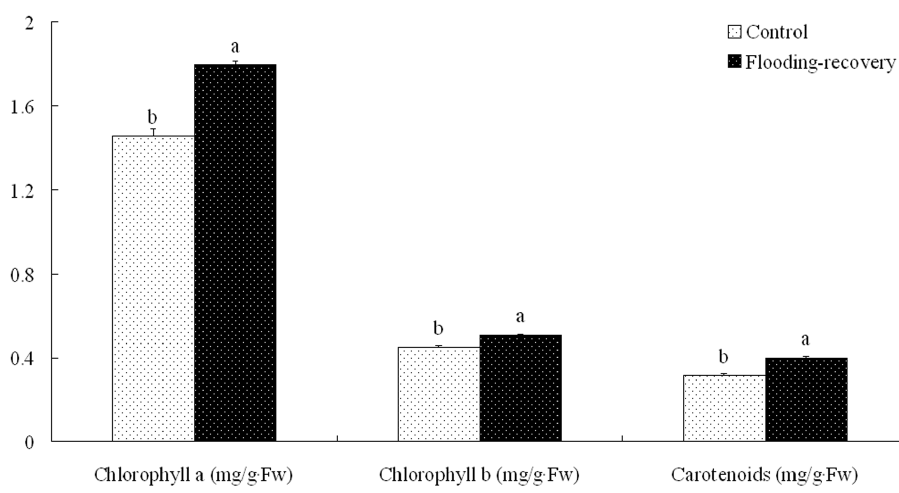
Figure 1. Comparable analyses of pigment contents in L.chinense during the recovery stage after winter flooding. Values are means 6 SE (n=6). The values followed by different letters significantly differed at P , 0.05 according to Duncan’s test.